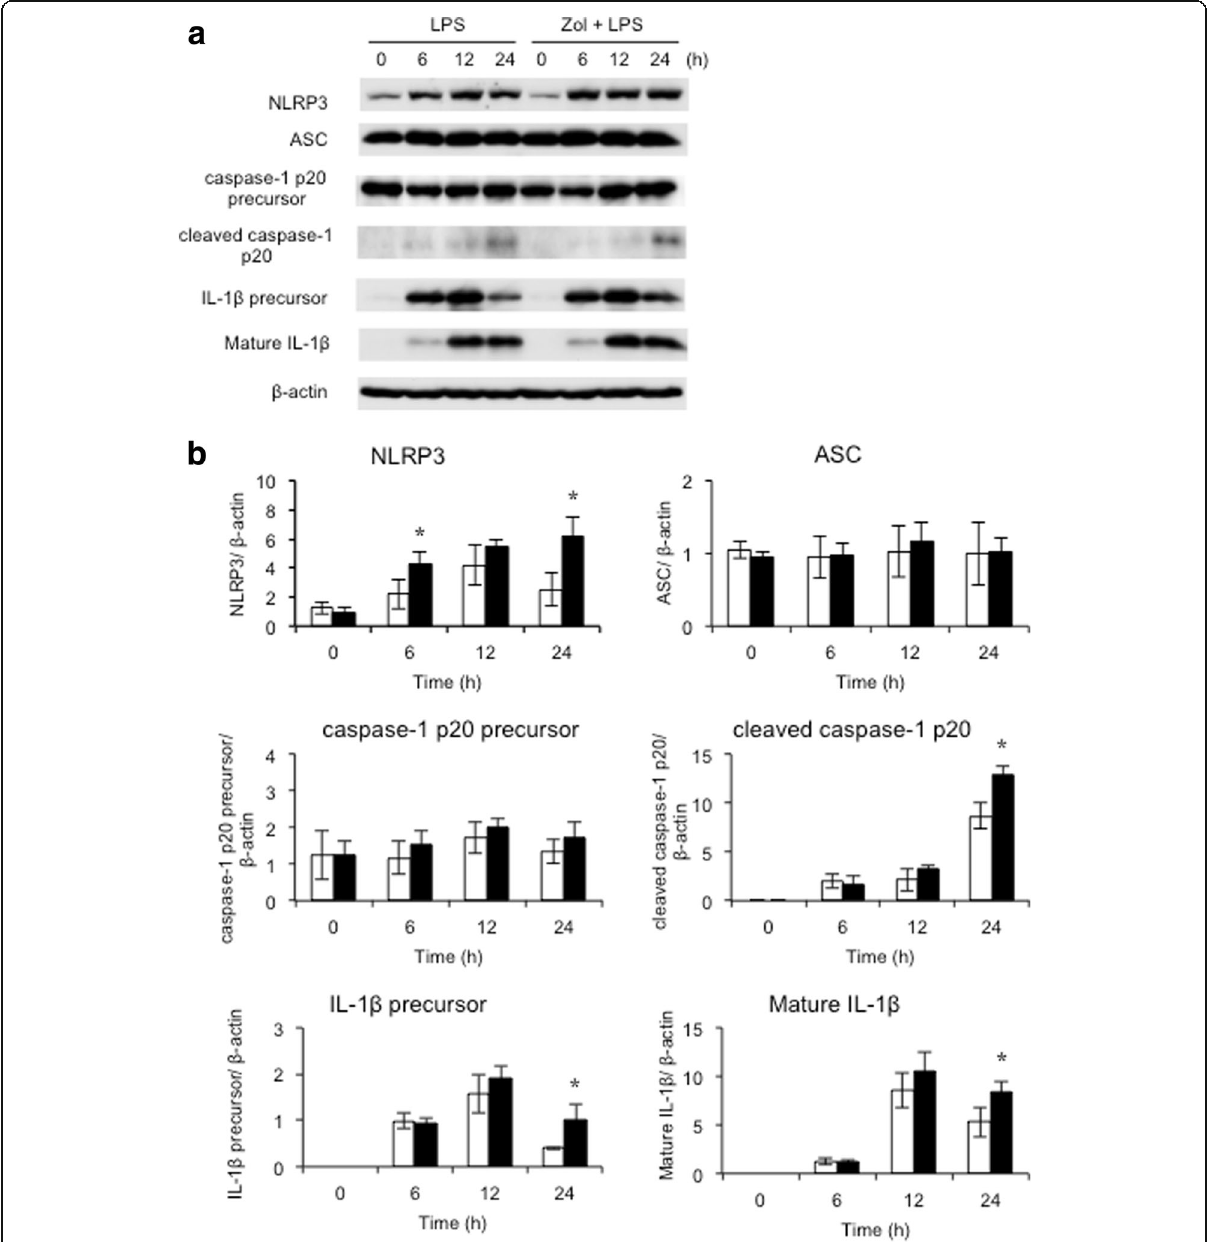
Fig. 2 Effects of zoledronic acid on the expression of inflammasome-associated proteins. THP-1 cells were treated overnight with 100 ng/ml PMA, washed with PBS, and incubated with or without Zol for 24 h. THP-1 cells were then treated with 100 ng/ml LPS. ATP was applied to LPS-treated cells for 30 min before collecting samples. a Protein expression was detected by western blotting. b Band intensities were measured by scanning densitometry. Data were normalized to β -actin expression. Open bars represent LPS-treated THP-1 cells; filled bars represent Zol and LPS-treated THP-1 cells. Zol promoted the expression of NLRP3, cleaved caspase-1 p20, IL-1 β precursor, and mature IL-1 β proteins in LPS-treated THP-1 cells (* P < 0.05 vs. cells treated with LPS